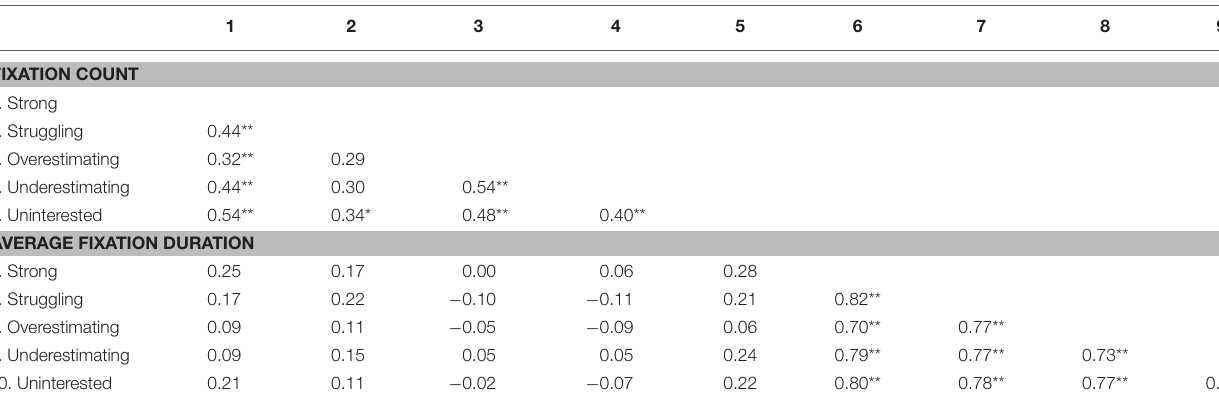
TABLE 2 | Intercorrelations for fixation count and average fixation duration across student